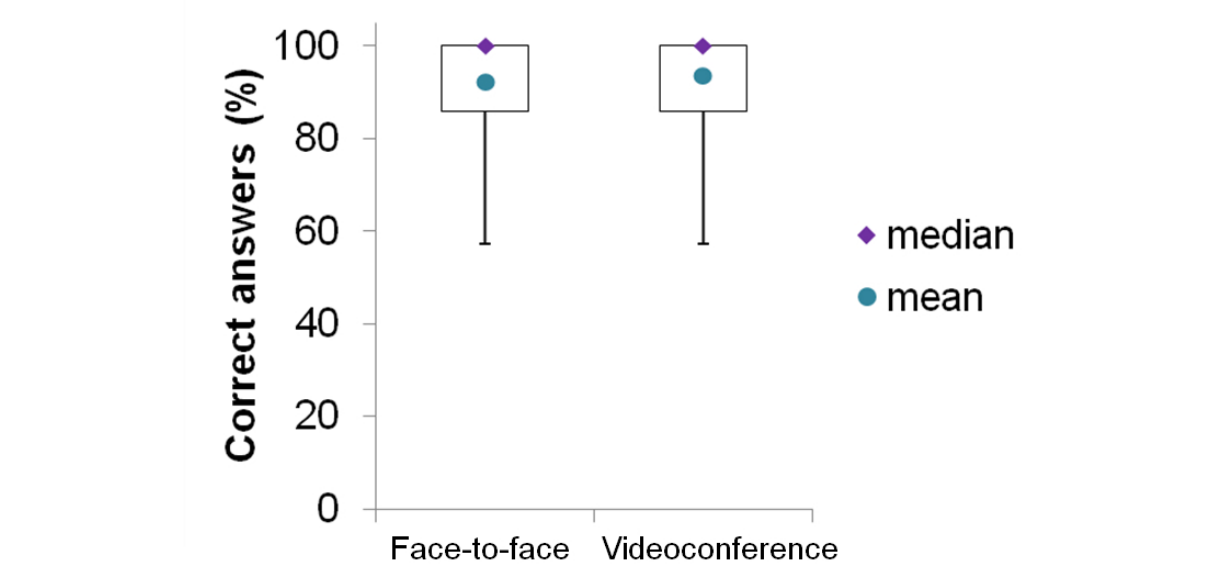
Figure 2. Results of the first part of patients’ evaluation regarding what they learned about OSA and CPAP therapy during the training session (study 2). The box-and-whickers plot shows the percentage of correct answers to the multiple choice test performed by the two randomized groups.